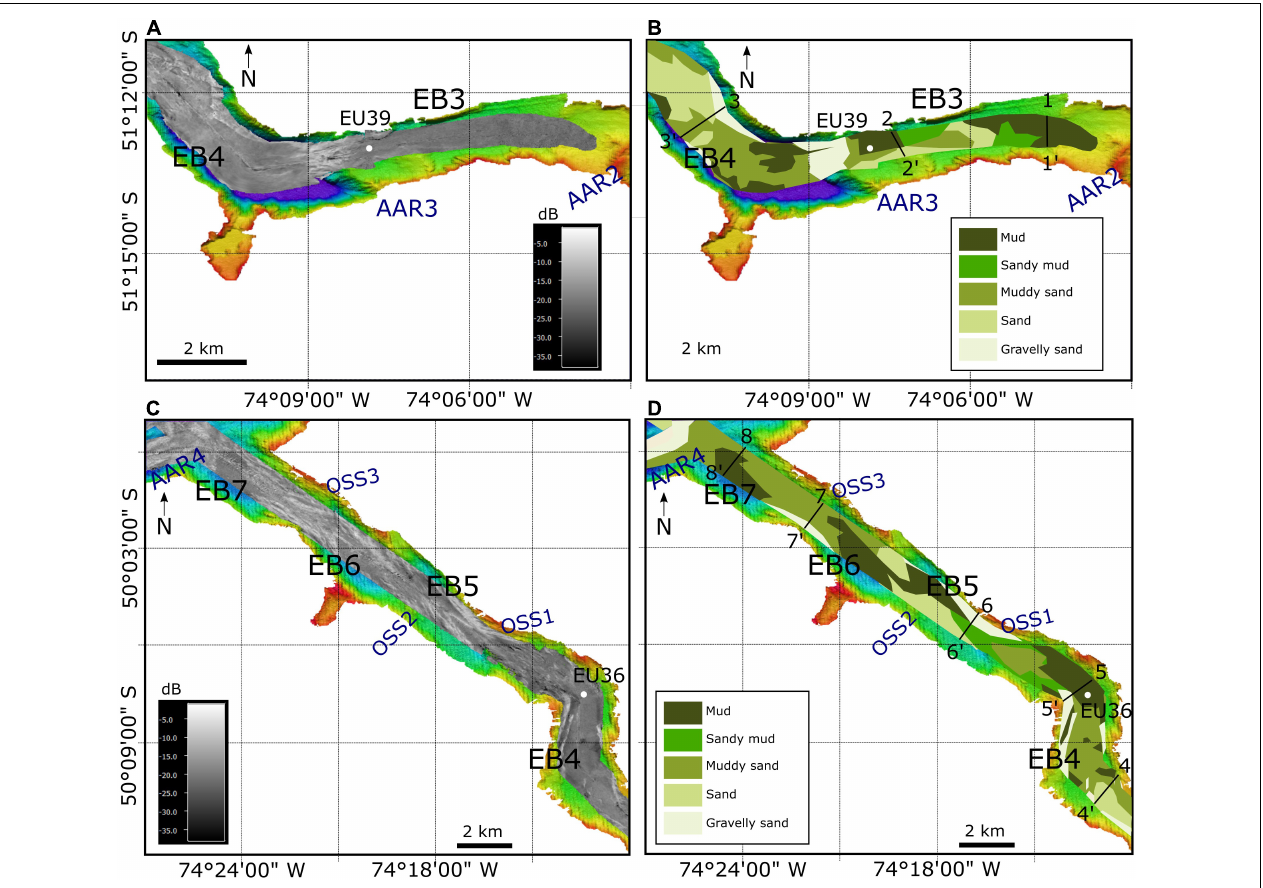
FIGURE 5 | Results from acoustic analysis from Cruise CIMAR 23 multibeam sonar data. (A) Backscatter image map for inner fjord area. (B) Seafloor sediment textural classification map for inner fjord area. (C) Backscatter image map for outer fjord area. (D) Seafloor sediment textural classification for outer fjord area. Location of the EU39 and EU36 sediment cores is shown, and example profile locations (e.g., 1–1’) for ARA analysis original results are in the Supplementary Material